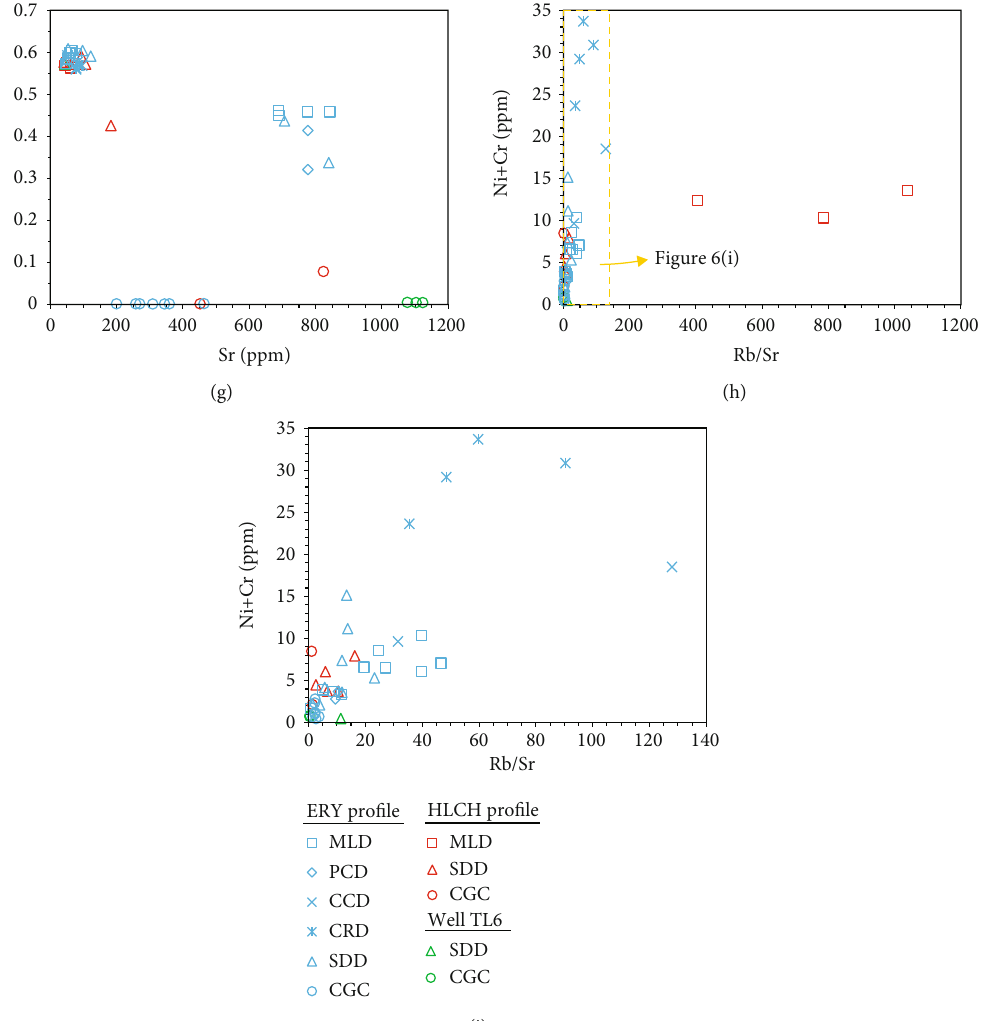
Figure 6: Binary diagrams of trace elements and ratios. PCD: partially clouded dolomite. MLD: mosaic-like dolomite. CCD: cloudy-centered dolomite. CRD: clear-rimmed dolomite. SDD: saddle dolomite. CGC: coarse-grained